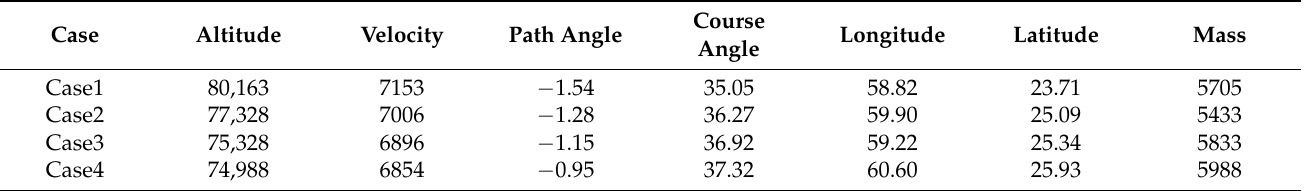
Table 5. Four cases in high energy status.